Question: What direction does the quantity move in — increasing or decreasing?
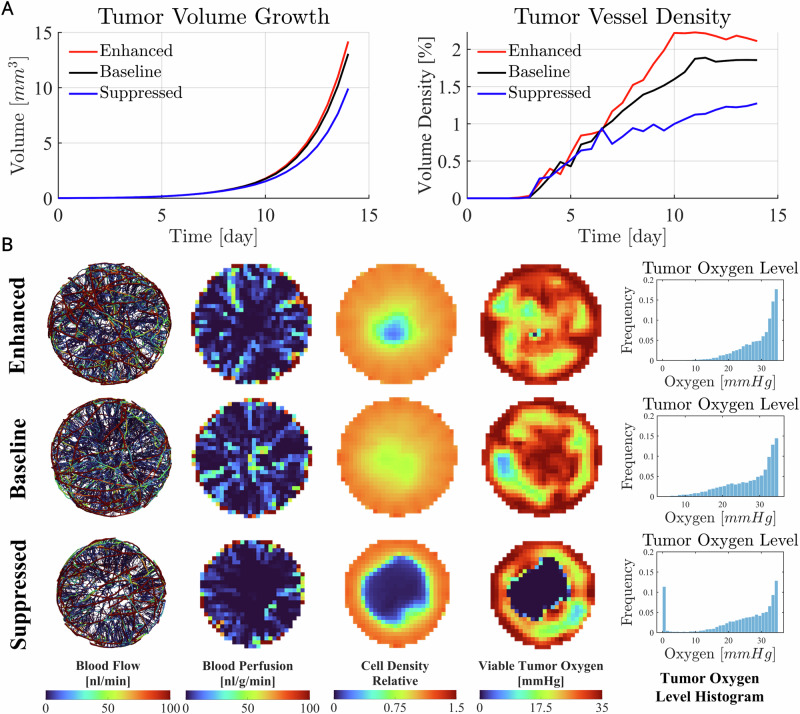
Answer: increasing